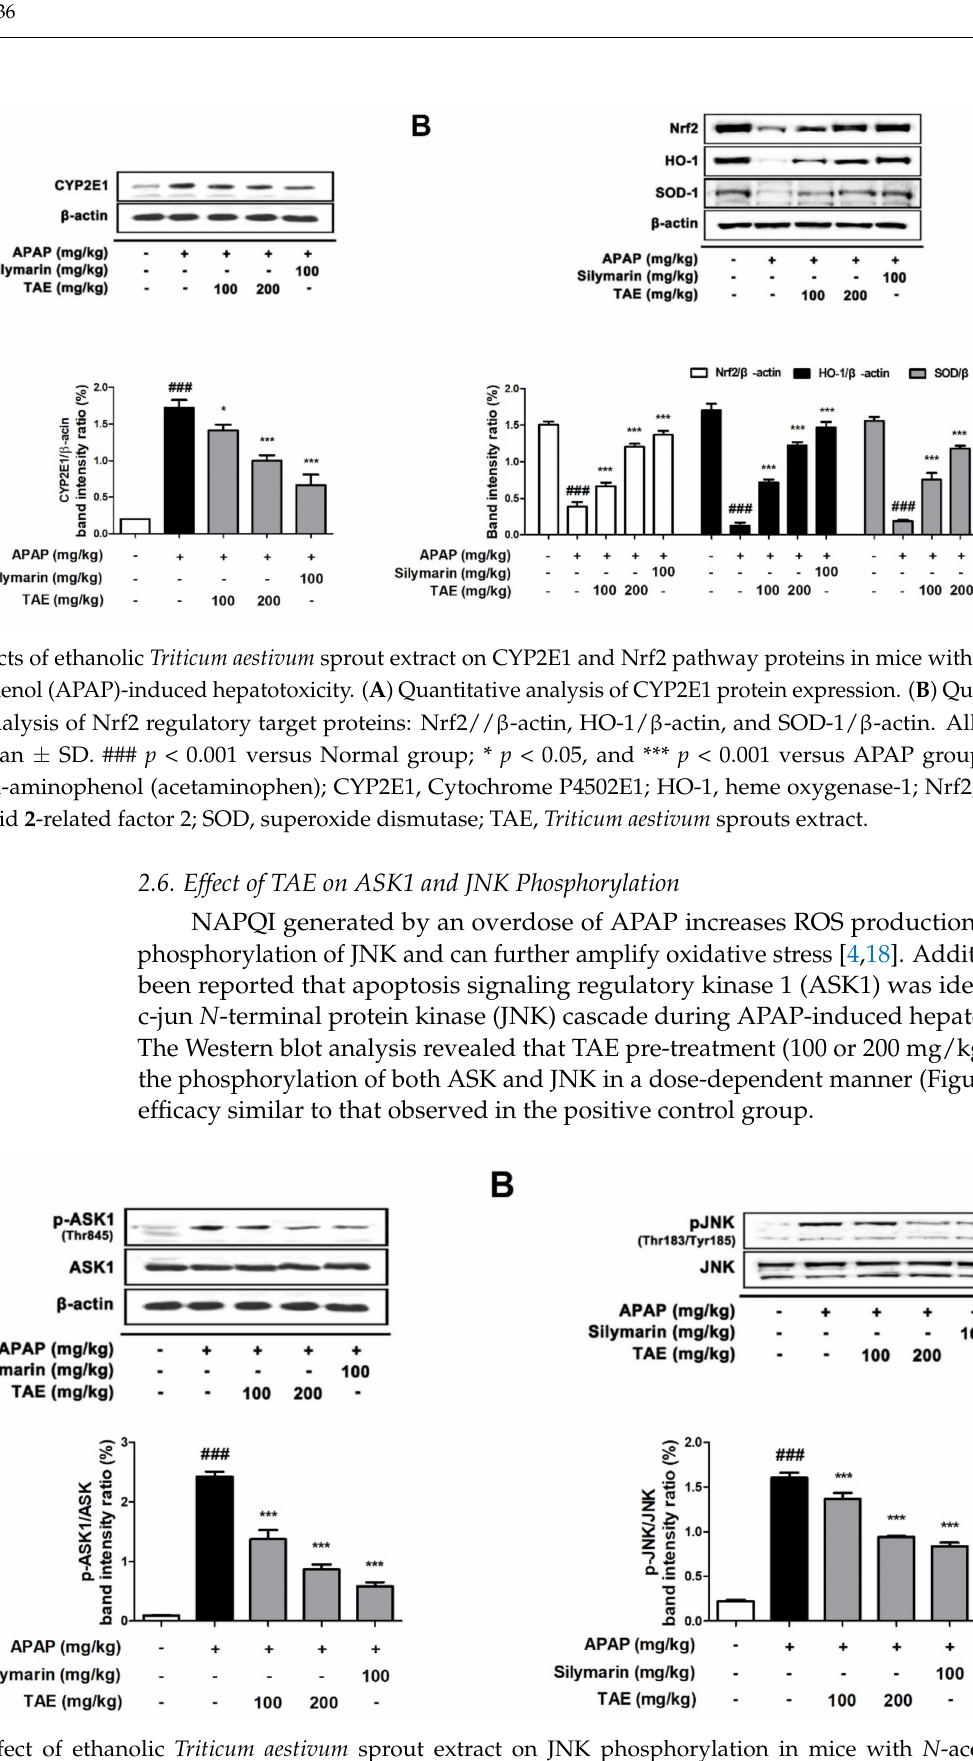
Figure 6. Effect of ethanolic Triticum aestivum sprout extract on JNK phosphorylation in mice with N -acetyl-para- aminophenol (APAP)-induced hepatotoxicity. ( A ) Quantitative analysis of phosphorylated ASK1 protein. ( B ) Quantitative analysis of phosphorylated JNK protein. The bar graph represents the quantitative band densities of pASK1/ASK1